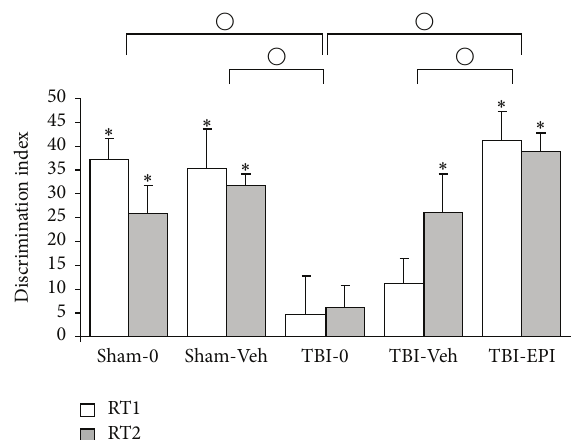
Figure 2: Mean value (+SEM) of the discrimination index at 3 h and 24 h retention tests. ∗ : statistically significant differences compared to zero; I : statistically significant differences between